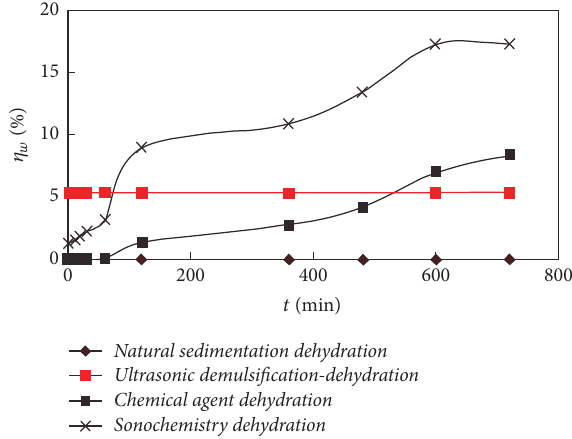
Figure 5: The comparison of demulsifying and dehydrating crude oil using ultrasonic excitation, natural sedimentation, chemical demulsifier, and sonochemistry method, respectively, at 40 ∘ C.